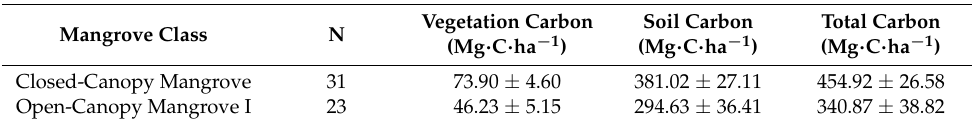
Table 4. Mean carbon densities of vegetation and soil carbon pools up to 100 cm ( ± SE) in Helodrano